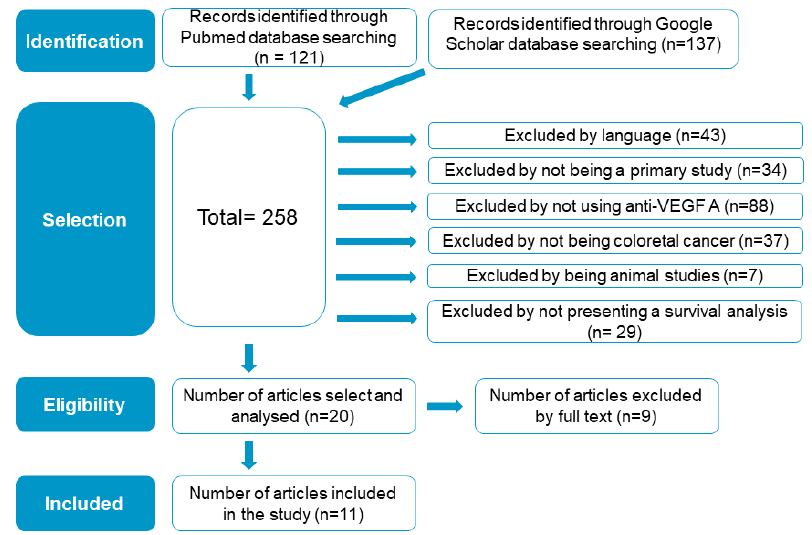
Figure 1. Flowchart following PRISMA (Preferred Reposting Item for Systematic Reviews and Meta-Analyses) statement.